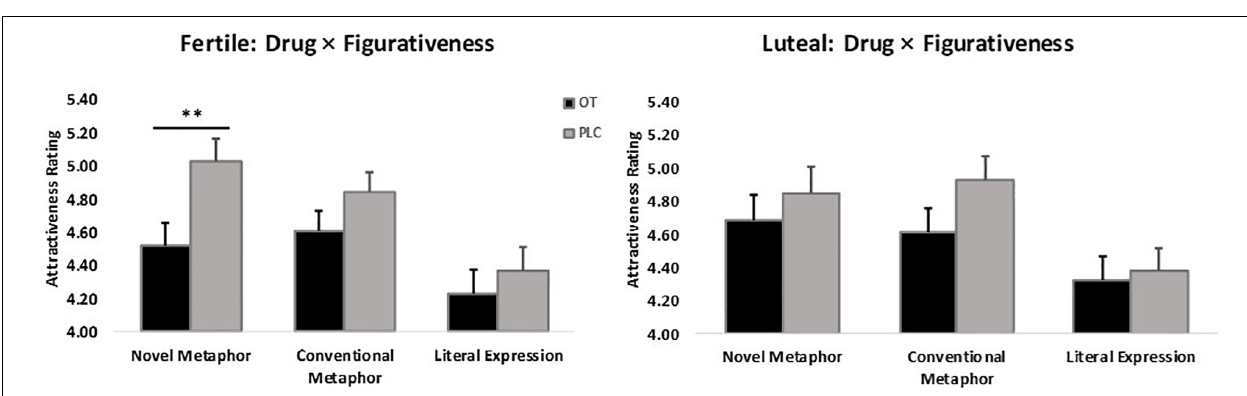
OT NM − luteal = 4.68 ± 0.16, PLC NM − luteal = 4.85 ±